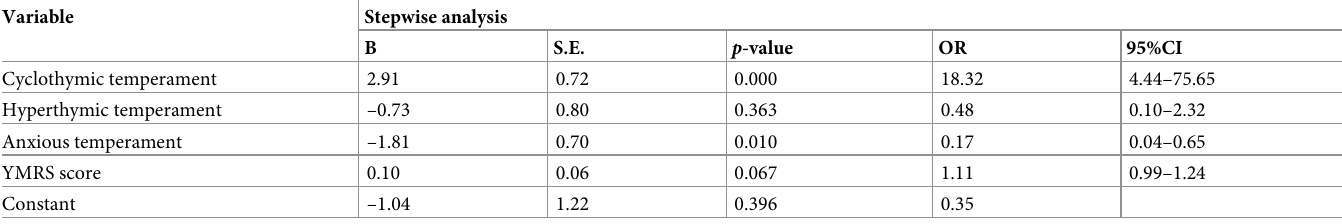
Table 3. Stepwise multivariate logistic regression analysis of the diagnosis of MDD and BD-II. Variable